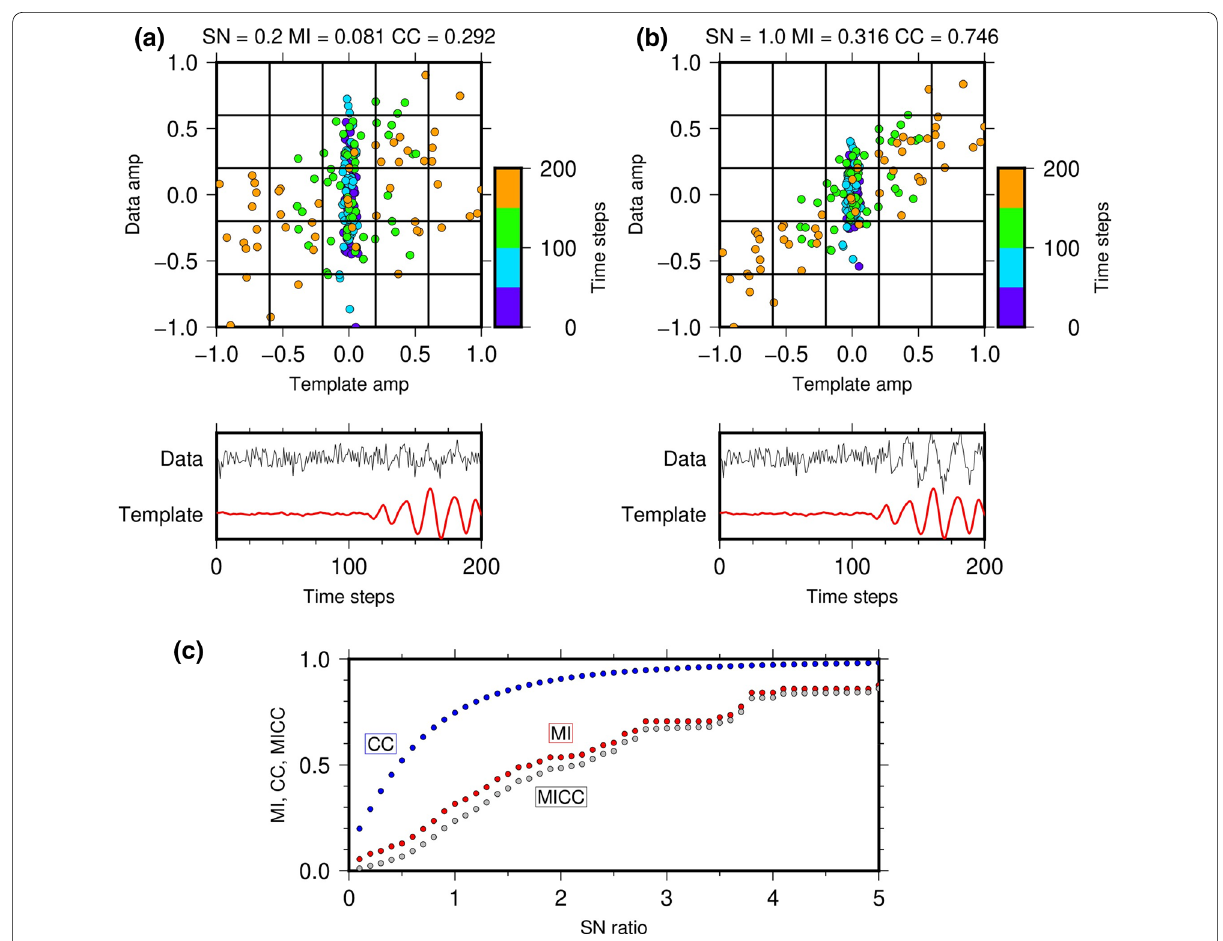
Fig. 4 a – b Scatter plots of detection using a waveform comprising a DLF earthquake signal with Gaussian noise at SN ratios of ( a ) 0.2 and ( b ) 1.0. A given time step represents each sample of velocity data in the 8-s time window (25 Hz sampling rate). Scatter plots (top panels) compare the amplitude of the template waveform with the amplitude of the target data at each time step. Bottom panels show the waveforms of the target data and template waveform at that time. c The three indices (MI, CC, and MICC) plotted with respect to the SN ratio of the